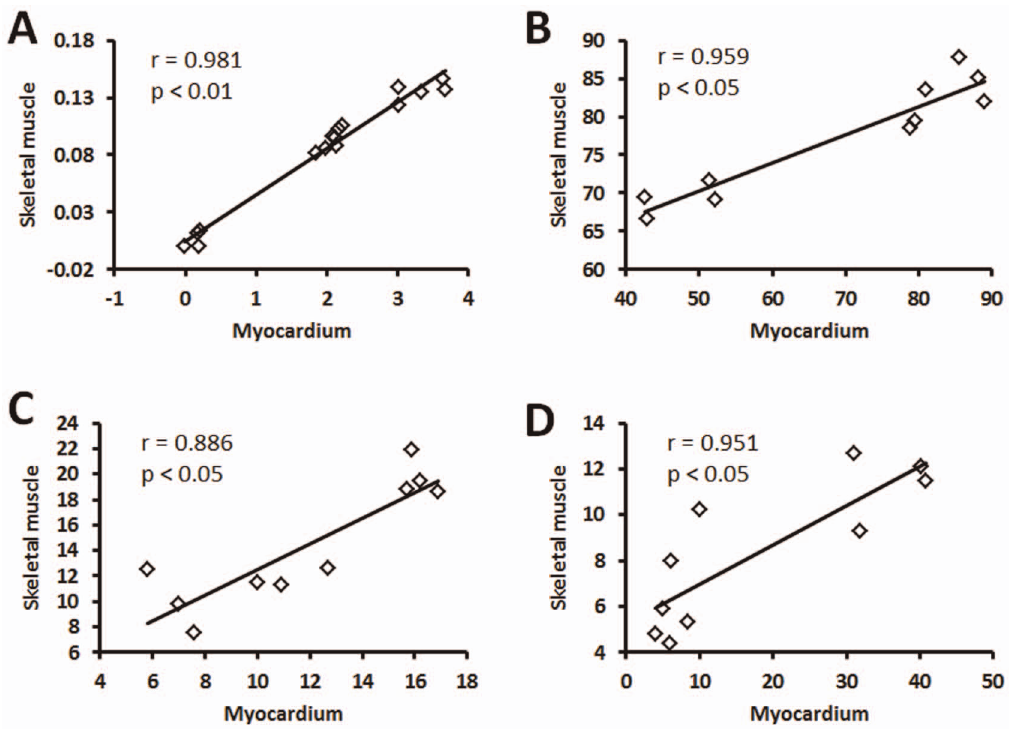
Fig. 3. The correlation curves of mtDNA deletion rate between myocardium and skeletal muscle, and mitochondrial membrane phospholipids loss rate between myocardium and skeletal muscle in VMC mice. The correlation of mitochondrial membrane phospholipids normal localization between myocardium and skeletal muscle in VMC mice was described in part b, R 5 0.959, p , 0.001; the correlation of partial loss of mitochondrial membrane phospholipids was described in part c, R 5 0.886, p 5 0.03; the correlation of most or complete loss was described in part d, R 5 0.951, p 5 0.001.